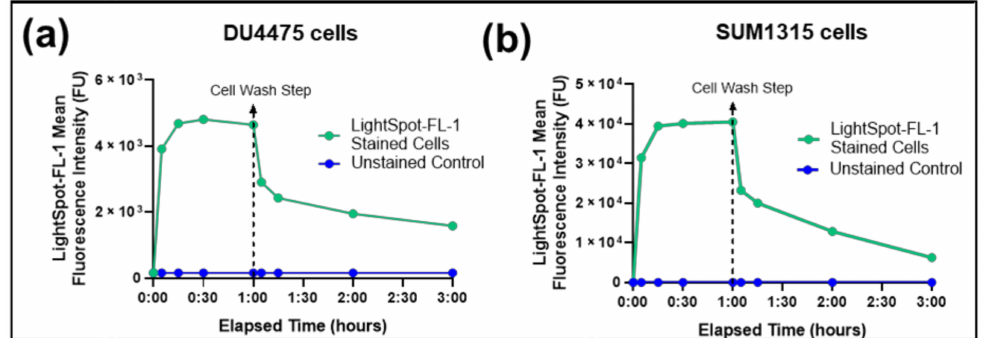
Figure 2. LightSpot ® -FL-1 kinetic uptake in DU4475 and SUM1315 TNBC cell lines. DU4475 ( a ) and SUM1315 ( b ) TNBC cells were exposed to a 1 µ M LightSpot ® -FL-1 fluorescent probe and the cellular fluorescence intensity (fluorescence units: FU) was measured at different times by flow cytometry analysis. After 1 h of exposure, DU4475 ( a ) and SUM1315 ( b ) cells were washed with culture medium (cell wash step) and the cellular fluorescence intensity was again measured at different times by flow cytometry, 2 h after the cell-wash step. During the entire experiment time, unstained cells were analyzed in parallel as control